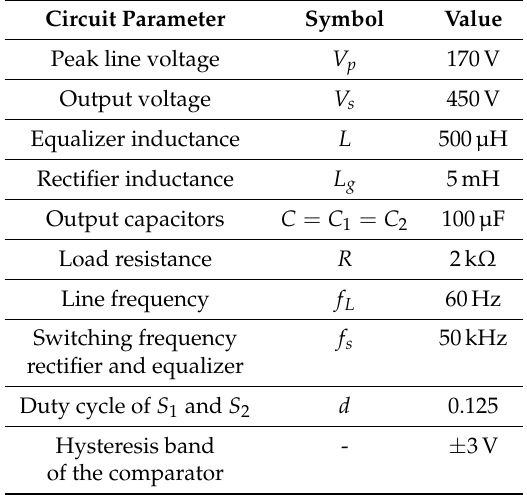
Table 5. Parameters of the voltage doubling step-up rectifier with the proposed equalizer circuit. Circuit Parameter Symbol